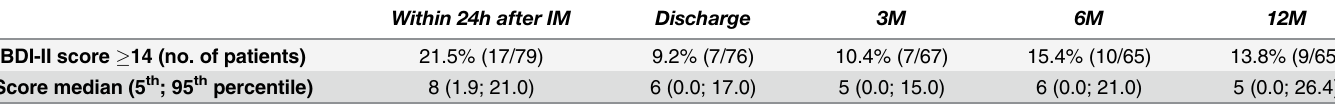
Table 1. Occurrence of positivity of questionnaire BDI-II. Within 24h after IM Discharge 3M 6M 12M BDI-II score (cid:1) 14 (no. of patients) Score median (5 th ; 95 th